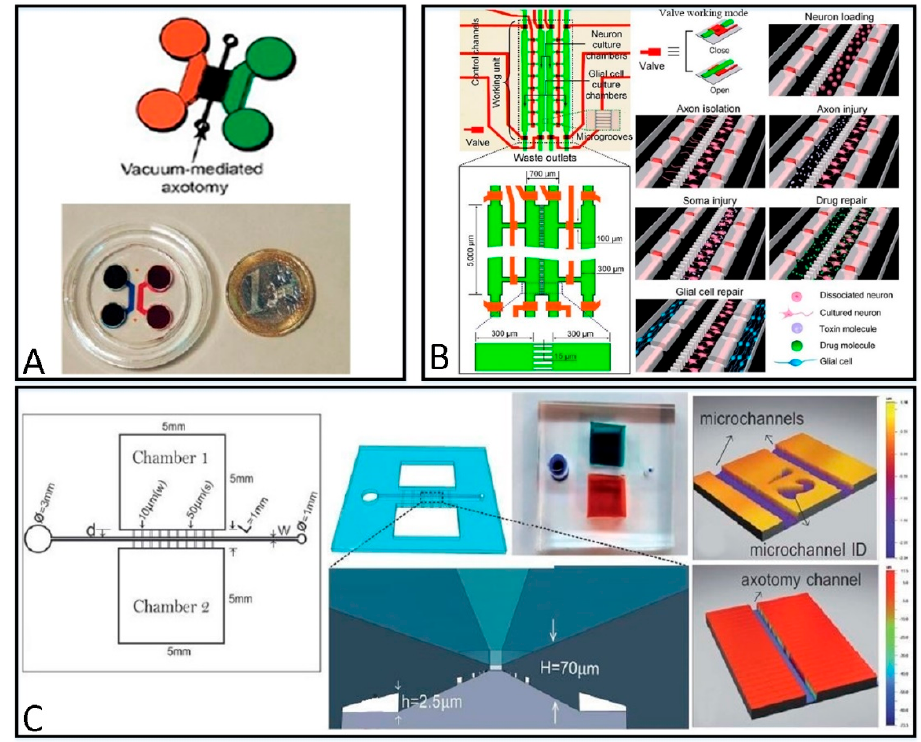
Figure 4. Microfluidic platforms for nerve repair. ( A ) Vacuum-assisted axotomy device by Sala- Jarque, J. ( B ) The schematic diagram of microfluidic device presented by Wang, J. for neuronal compartmentalized injury and regeneration research. The fluidic layer has a micron-scale fluidic network (left part) and contains four parallel cell culture chambers. Two chambers in the middle are used for neuronal culture and are connected by an optimized microslot structure. Two external chambers are connected to the neuronal culture chamber using eight parallel microchannels that are designed for glial cell culture. ( C ) The schematics of axotomy microfluidic device designed by Tong, Z. The microchannels for placing neural axon are intersected by an axotomy channel.